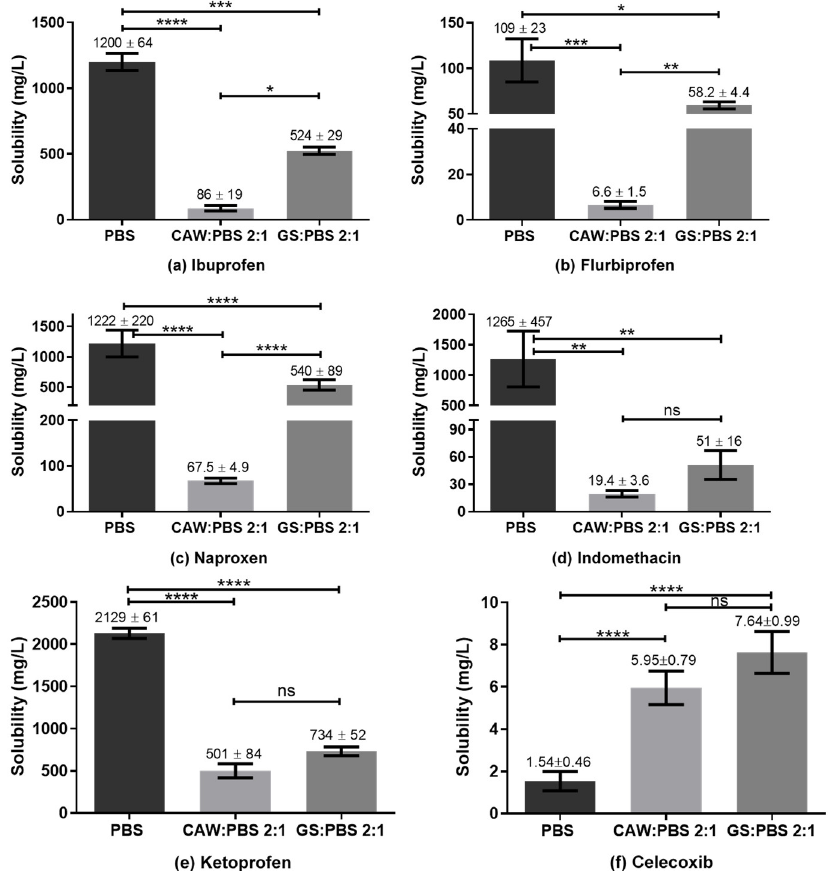
Figure 6. Solubility of NSAIDs in PBS, CAW:PBS 2:1, and GS:PBS 2:1 ( w / w ). **** p < 0.0001; *** p ≤ 0.0007; ** p ≤ 0.01; * p ≤ 0.03; ns p > 0.1.